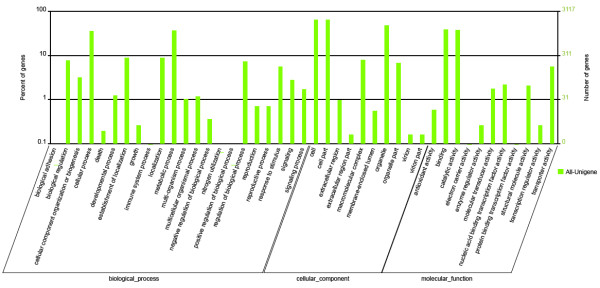
Histogram of gene ontology classification. The results are summarized in three main categories: biological process, cellular component and molecular function. The right y-axis indicates the number of genes in a category. The left y-axis indicates the percentage of a specific category of genes in that main category.